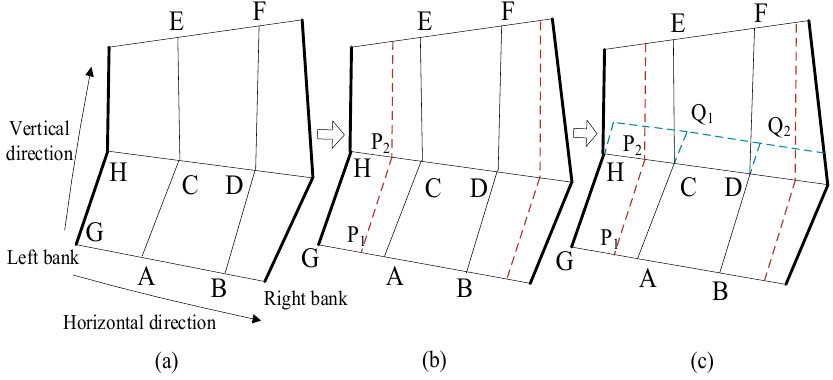
Figure 6. Three-layer water surface construction: ( a ) basic surface division; ( b ) vertical fusion zone; ( c ) horizontal fusion zone.